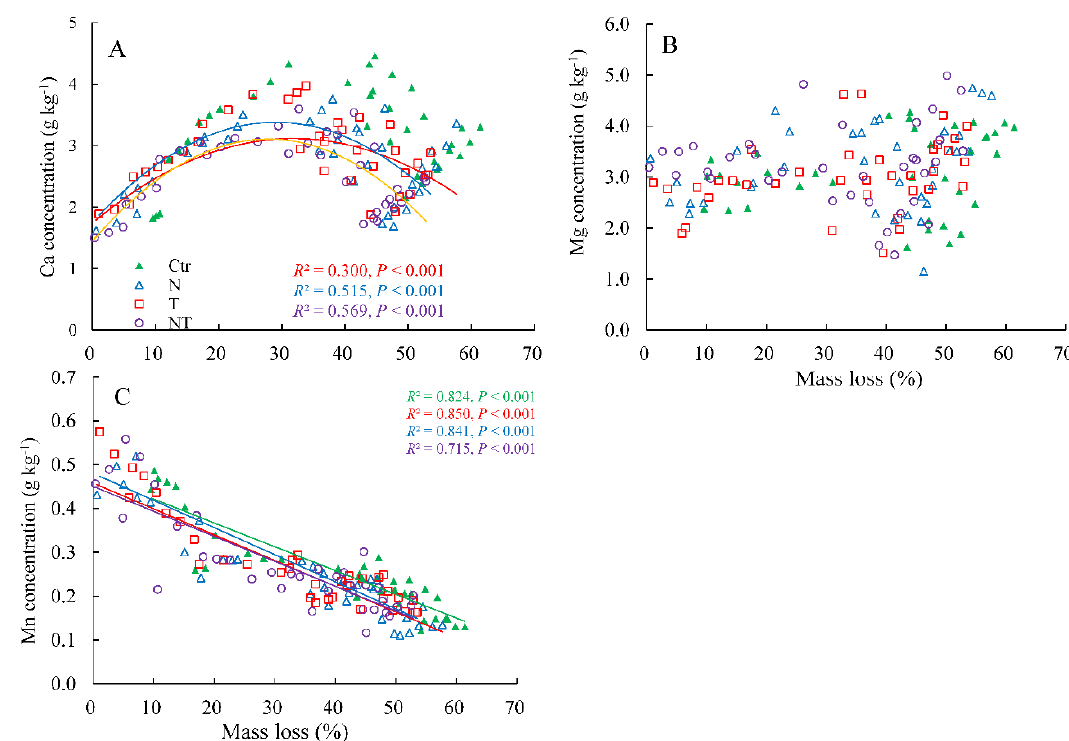
Figure 3. Relationships between Ca ( A ), Mg ( B ), and Mn ( C ) concentrations and mass loss in different treatments. Abbreviations of treatments are given in Figure 1.